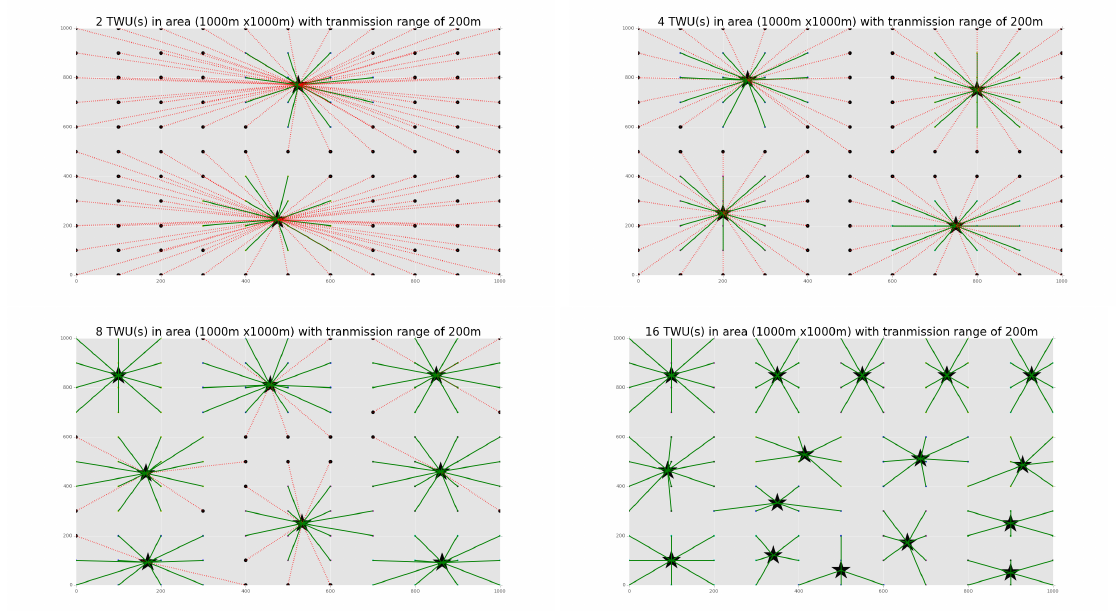
Figure 3. Simulation results considering various numbers of TWUs (2, 4, 8, 16) and particular